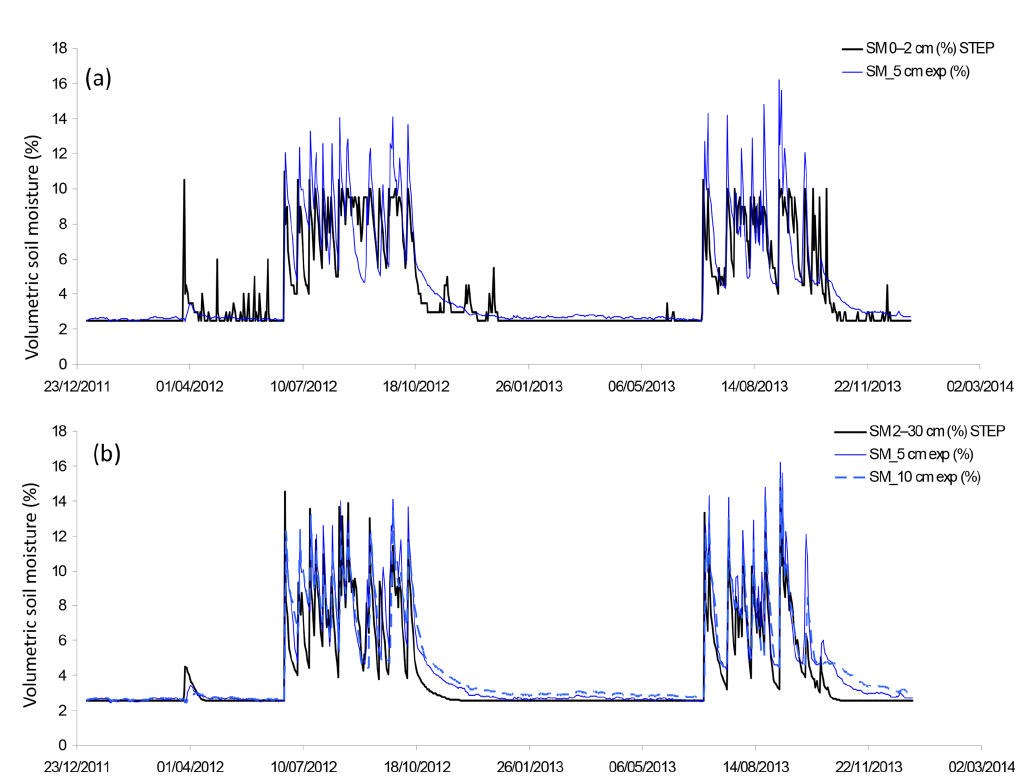
Figure 2. (a) Volumetric soil moisture simulated by STEP in the first layer (0–2cm) in black and soil moisture measured at 5cm in blue, as a percentage, at a daily scale. (b) Volumetric soil moisture simulated by STEP in the second layer (2–30cm) in black, soil moisture measured at 5cm as a blue solid line, measured at 10cm as a blue dotted line, as a percentage, at a daily